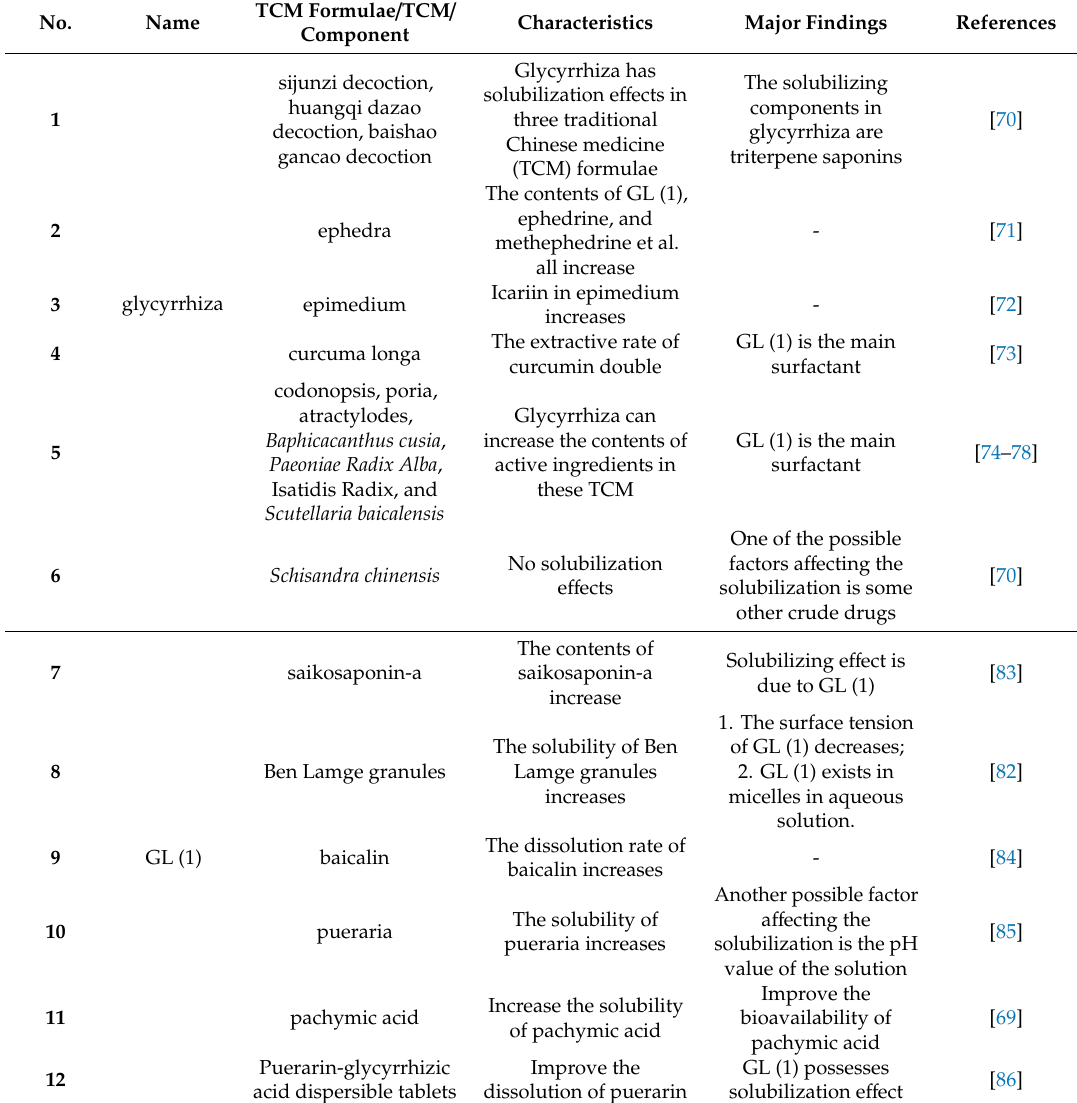
Table 3. Summary on solubilization of glycyrrhiza and GL ( 1